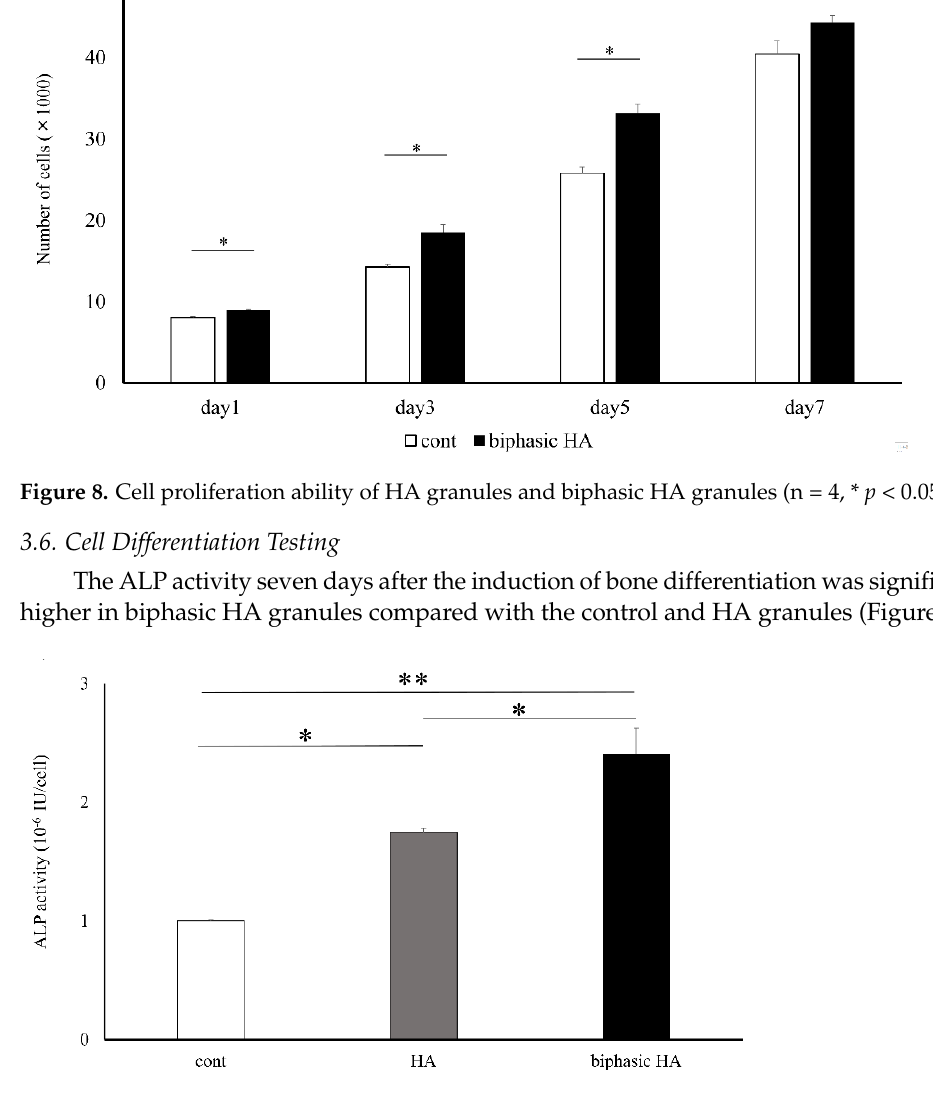
9 of 17 Figure 7. Stereo microscopic and SEM images of HA granules. ( a ): Stereo microscopic image of HA granules. ( b ): Stereo